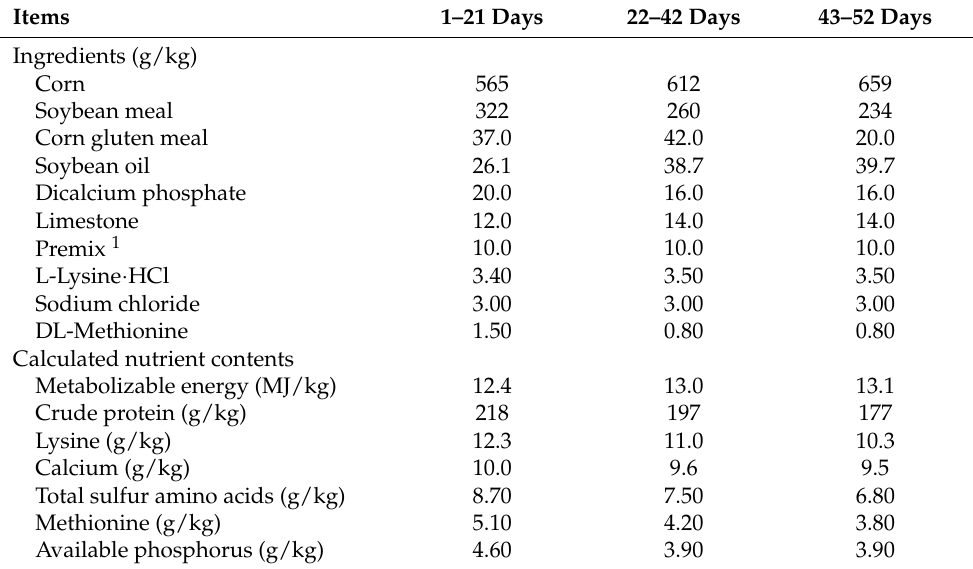
Table 1. Composition and nutrient contents of basal diets (as-fed